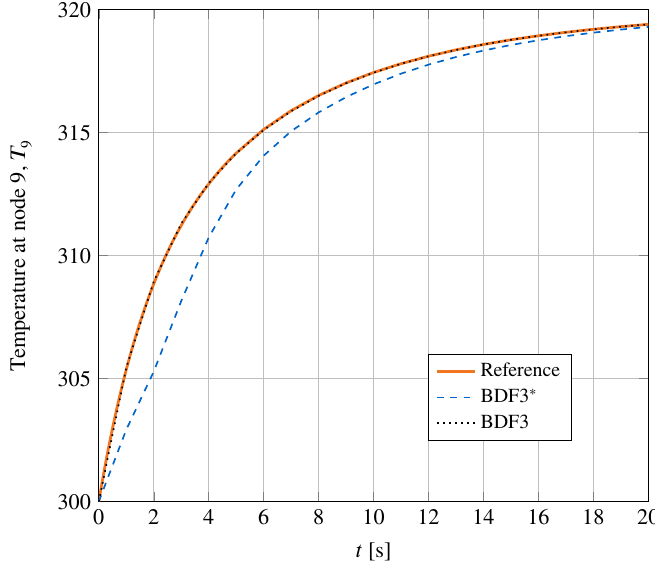
Figure 15. Synchronous motor: First, 20 s of the time history of the temperature at node 9, T 9 , obtained with h = 1